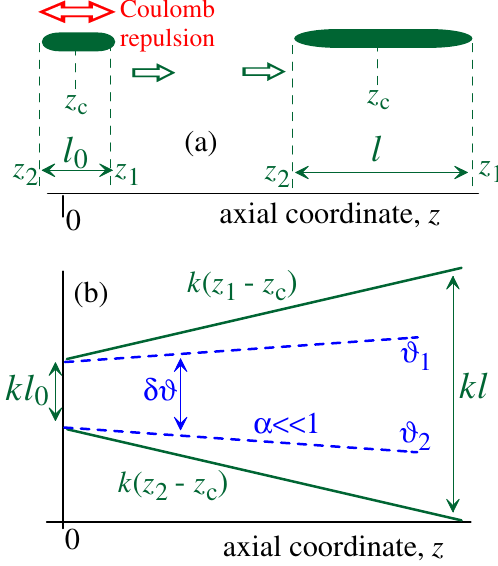
FIG. 4. (a) Enhancement of the axial length of the electron bunch in the process of its motion due to the Coulomb repulsion. (b) Characteristic evolution of axial coordinates of the electrons placed in the front and in the tail of the bunch (particles 1 and 2, respectively), as well as the evolution of phases of these two particles in the case of a small factor α . Here, z coordinate of the bunch